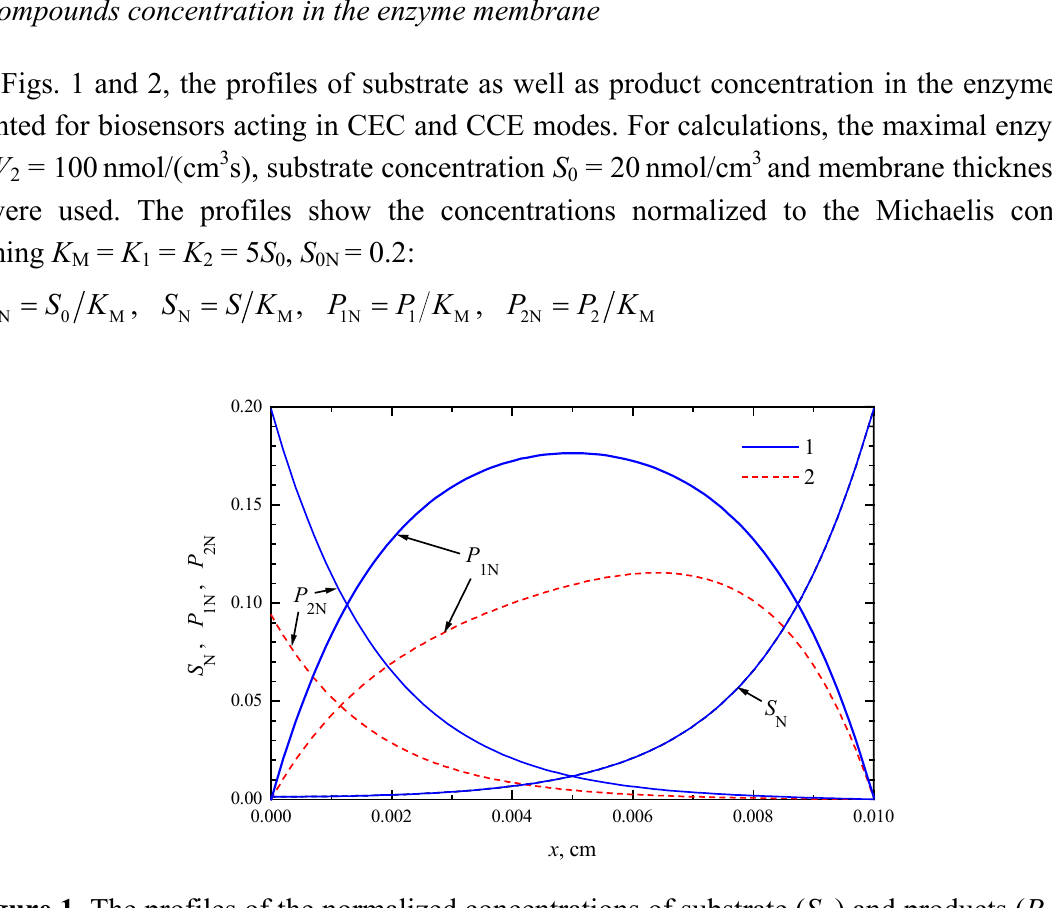
Figure 1 . The profiles of the normalized concentrations of substrate ( S in the enzyme membrane of a CEC biosensor at the maximal enzymatic rate V nmol/(cm 3 s), S = 0.2, d = 0.01 cm. The profiles show the concentrations at the steady-state 0N time t = 123 s (1) and half time t = 12 s